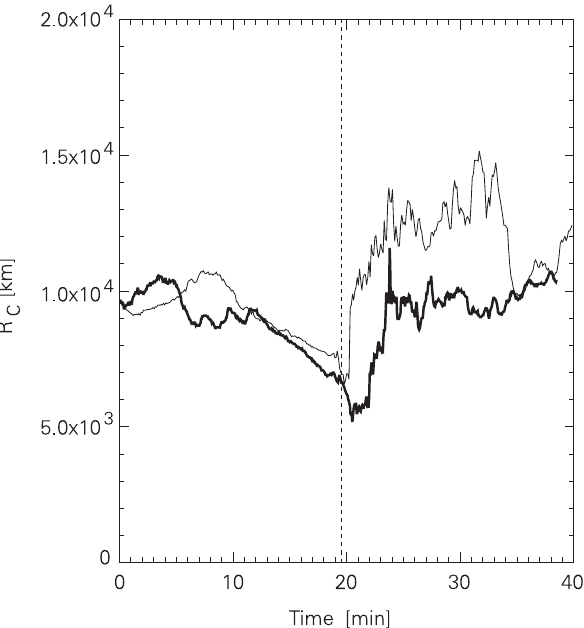
Fig. 2. The temporal variation of the equatorial curvature radii of the magnetic field lines threading AMPTE/CCE (thin line) and GOES-5 (thick line). The vertical dashed line marks the timing of the increase in the H component at AMPTE/CCE. AMPTE/CCE was located tailward and very close to